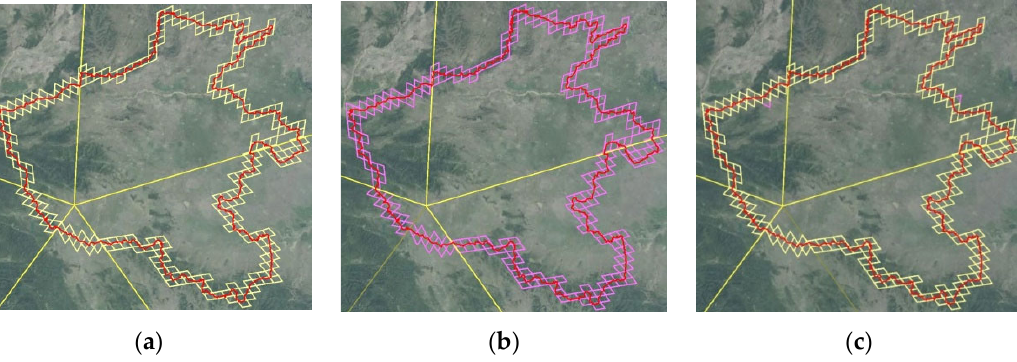
Figure 17. Comparison diagram of the ninth level diamond discrete lines of TtoDcode and longi ‐ tude–latitude. ( a ) The ninth level diamond discrete lines of longitude–latitude; ( b ) the ninth level diamond discrete lines of TtoDcode ; ( c ) the ninth level discrete lines superposition of longitude–latitude and TtoDcode .